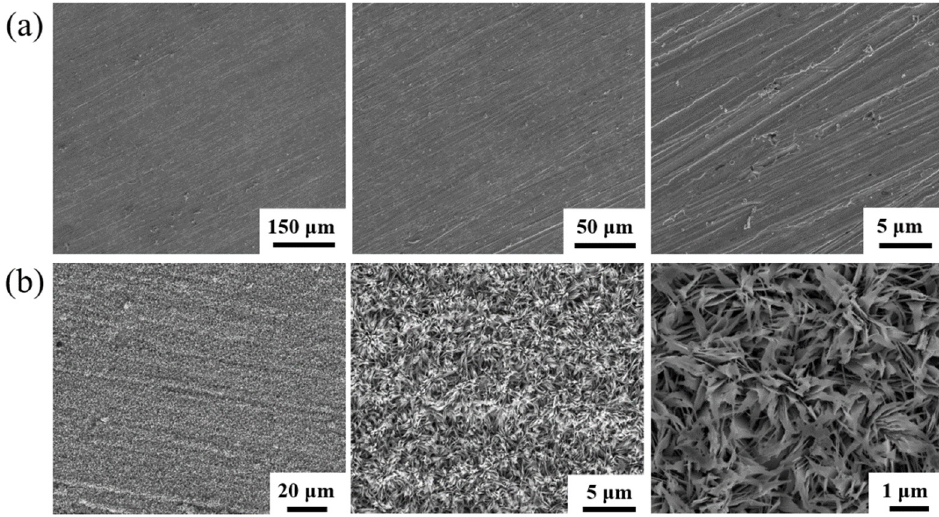
Figure 1. SEM images of ( a ) smooth hydrophilic surface ( b ) micro/nanostructured superhydrophilic surface.